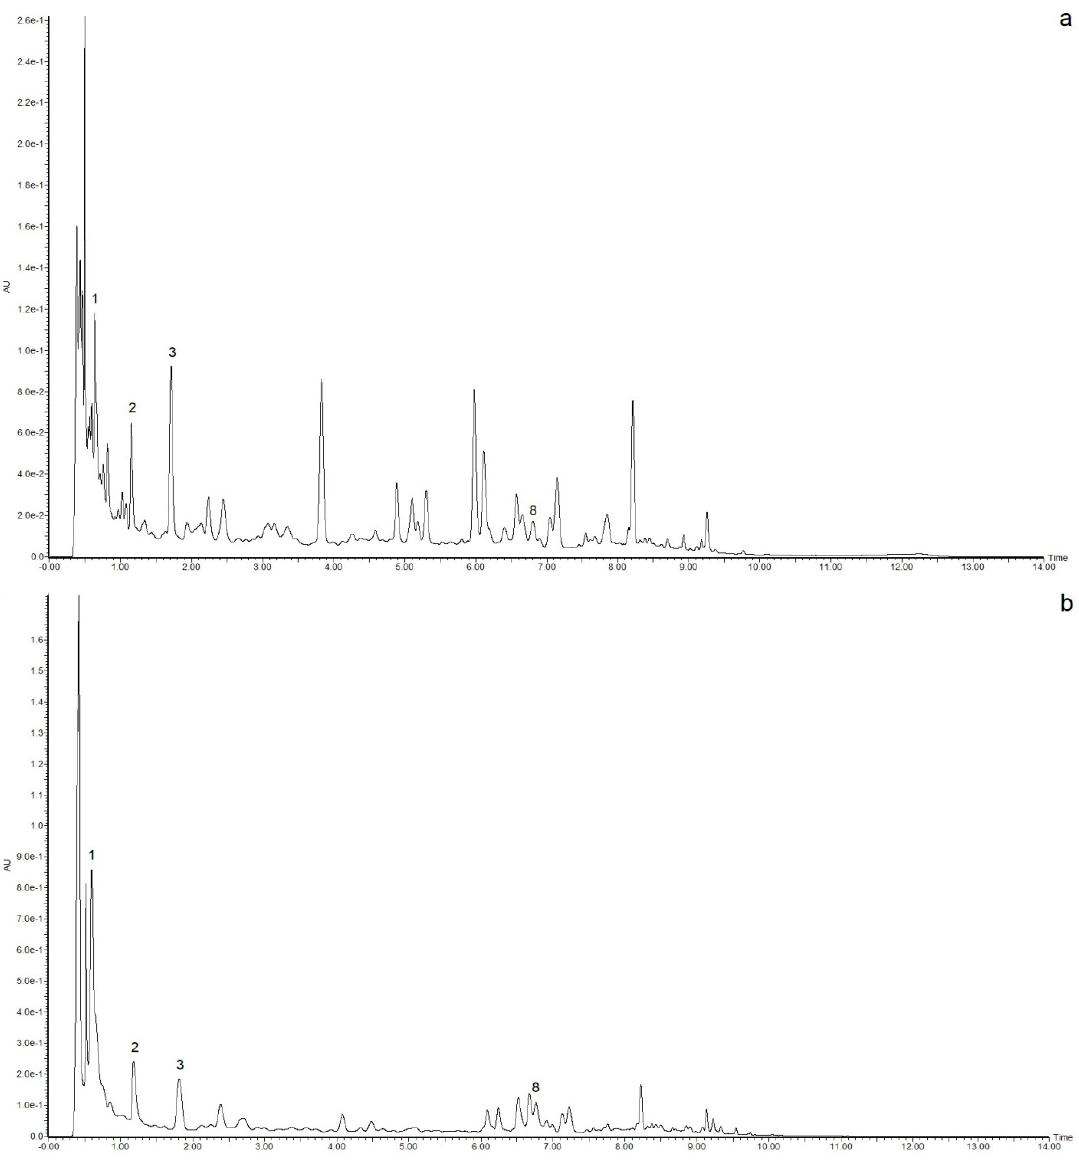
Figure 4. UPLC chromatograms of the methanolic extracts of the bioactive compounds of edible parts of red ( a ) and yellow ( b ) plums at 280 nm, [y axis = intensity (absorbance unit, AU); x axis = retention time (min)].